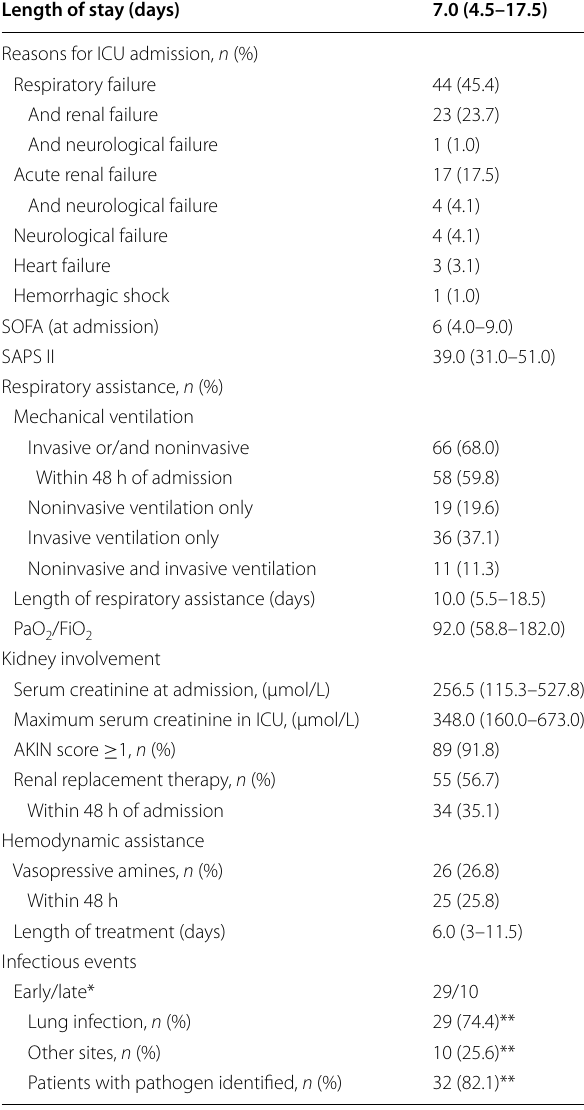
Table 2 Characteristics and supportive therapies used with ICU-AAV